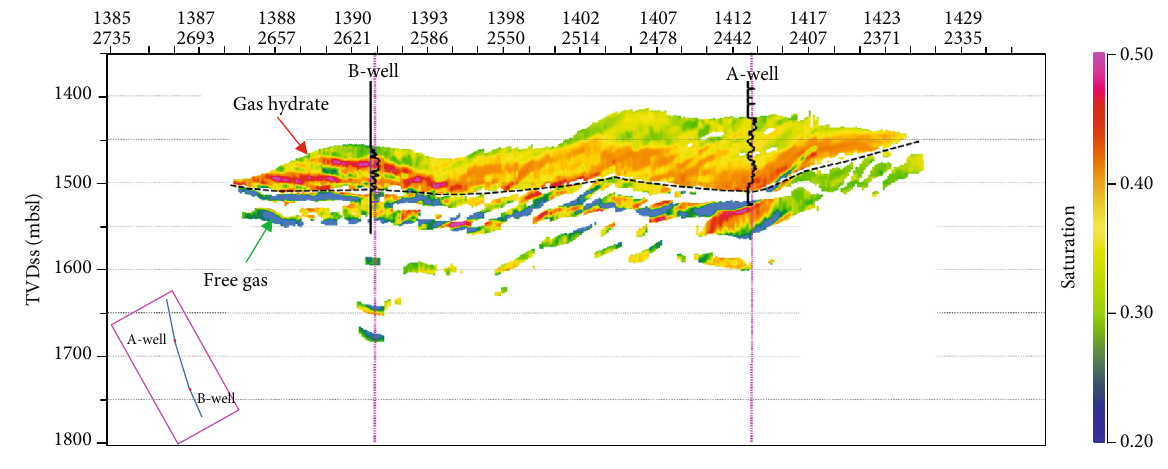
Figure 16: Well-tie saturation cross section of the A-well and